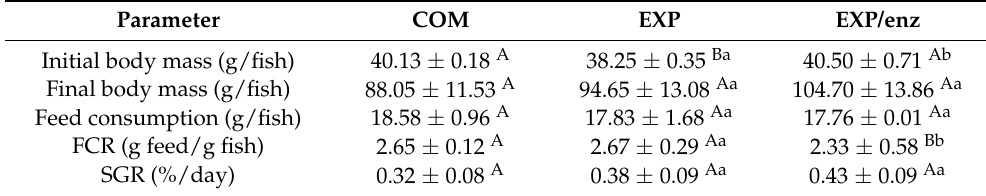
Table 5. Growth and feed efficiency in fish fed on the experimental diets in the field trial. Parameter COM EXP EXP/enz Initial body mass (g/fish) 40.13 ± 0.18